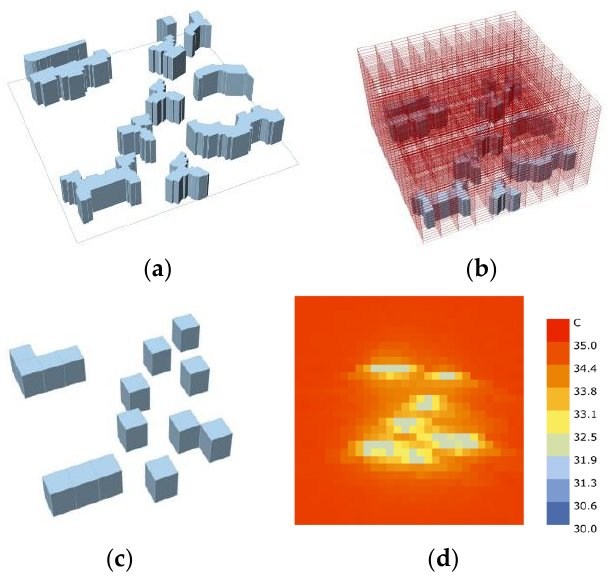
Figure 4. Building dataset generation process: ( a ) original building case, ( b ) orthogonal network is used to determine the architectural form and convert it into a 2D matrix, ( c ) transform the 2D matrix into 3D, and ( d ) UTCI distribution of the site is calculated using the recoded form and converted into a 2D matrix.